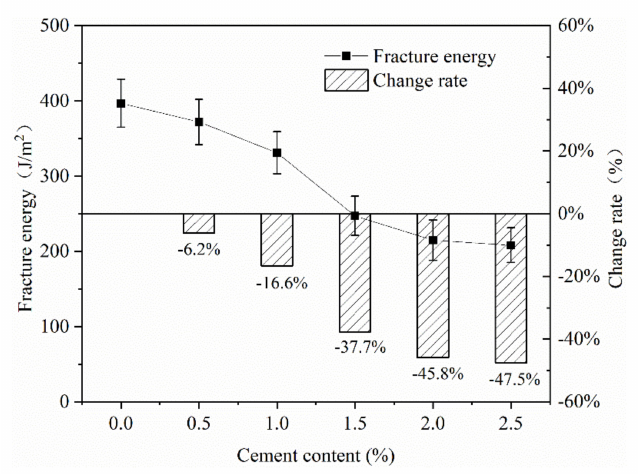
Figure 13. E ff ect of cement content on fracture